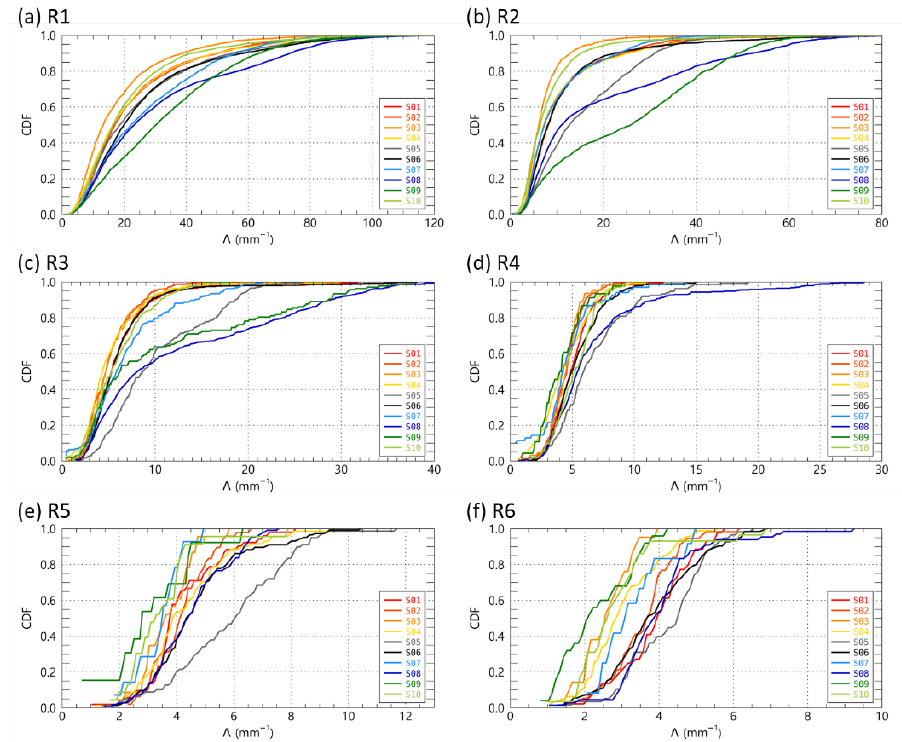
Figure 10. Th e cumulative distribution function of Λ (mm −1 ) for rain rate categories at the 10 Parsivel sites.